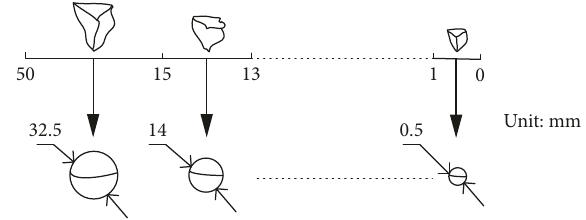
Figure 9: The schematic diagram of the fragments transformed into a sphere [40].